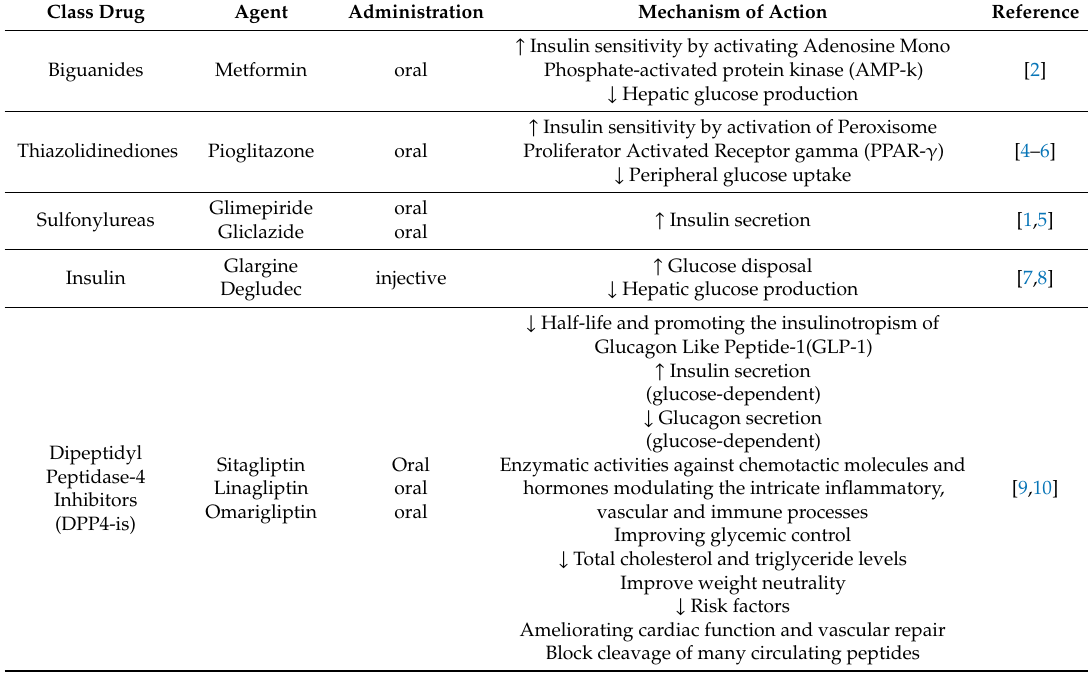
Table 1. List of the main glucose-lowering medications and their mechanisms of action for Type 2 Diabetes and implicated in cardiovascular outcome trial